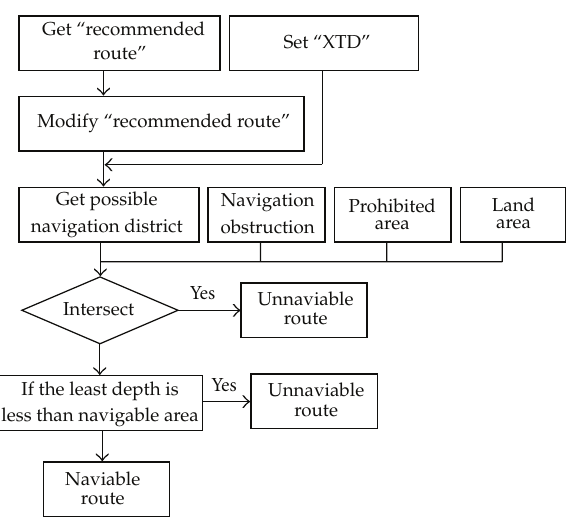
Figure 1: The simulation flow of route